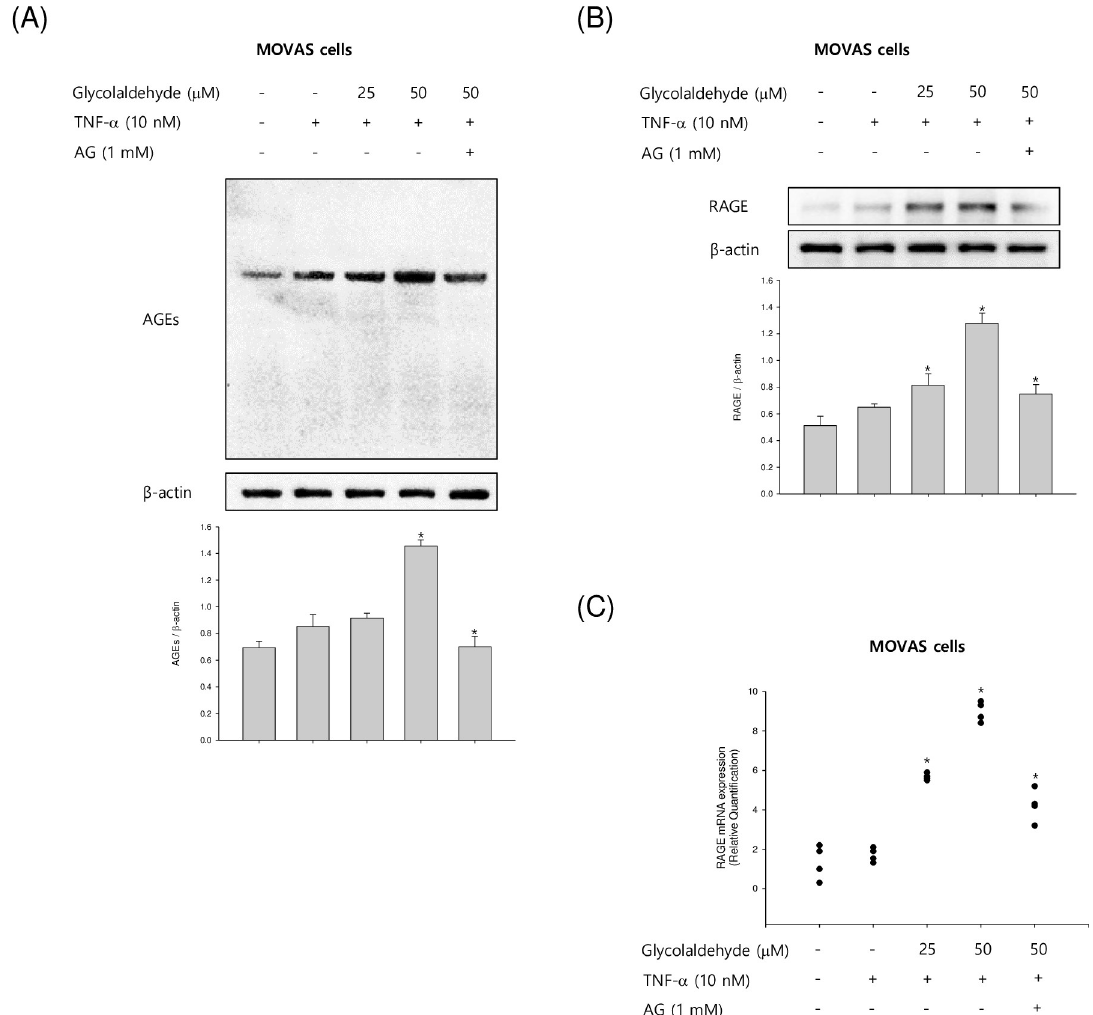
Fig 2. Effects of GA on the expression of AGE and RAGE in TNF- α -stimulated VSMCs. (A and B) The mouse VSMCs, MOVAS-1 cells, were incubated with TNF- α (10 ng/mL) in the presence or absence of GA (25 and 50 μ M) for 24 h. (B) MOVAS-1 cells were stimulated with TNF- α (10 ng/mL) in the presence or absence of GA (25 and 50 μ M) for 4 h. The whole cell lysates were investigated by western blot assay. Results are shown as means ± SEM from a representative experiment (n = 5). � p < 0.05 significantly different from the group treated with TNF- α